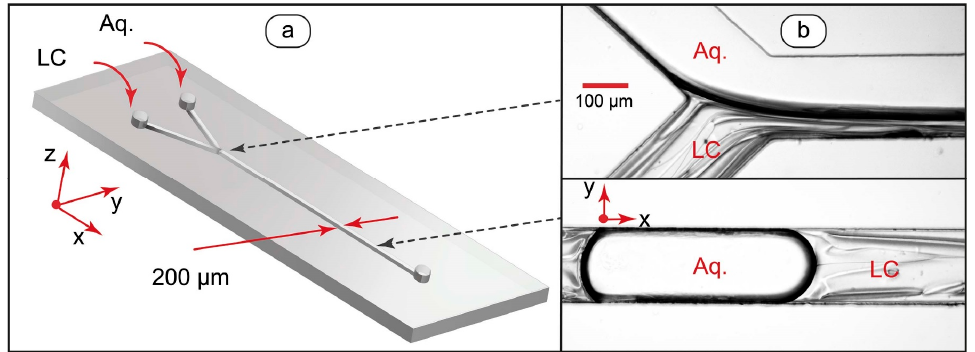
Figure 1. Design of microfluidic device for generating liquid crystal flows ( a ) and optical microscopy images of LC-water droplets and threads in microchannels ( b